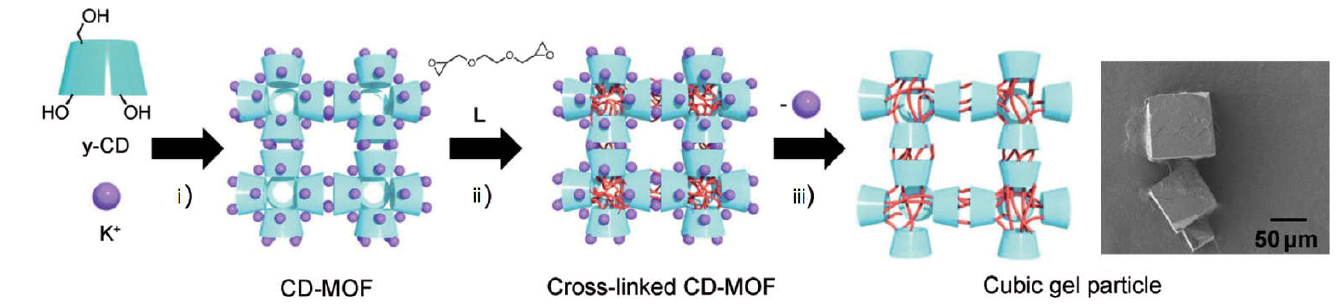
Figure 5. Overview of the preparation steps for the K + - γ -CD-MOF and its derived cubic-shaped gel: ( i ) the MOF is prepared from K + and γ-CD by crystallisation; ( ii ) γ-CD-MOF crystals are treated with the cross-linking agent (L); ( iii ) K + ions are removed to obtain the gel particles, which retain the cubic shape as demonstrated by its SEM image (right). Reprinted with permission from Furukawa et al . [41].